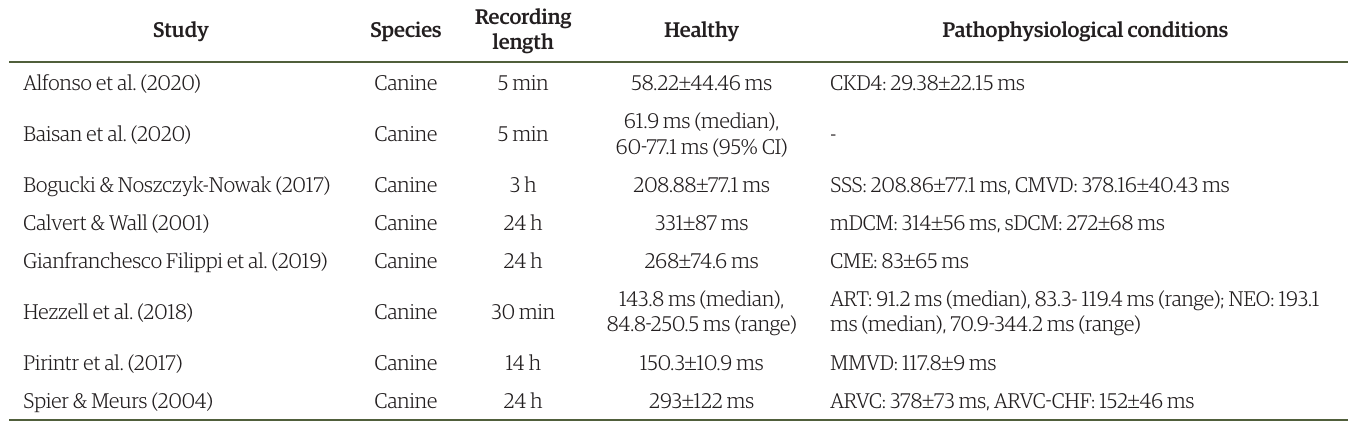
Table 1. Summary results of selected studies from the literature, depicting the recording length for data acquisition and the SDNN values for healthy animals or those presenting pathophysiological conditions.